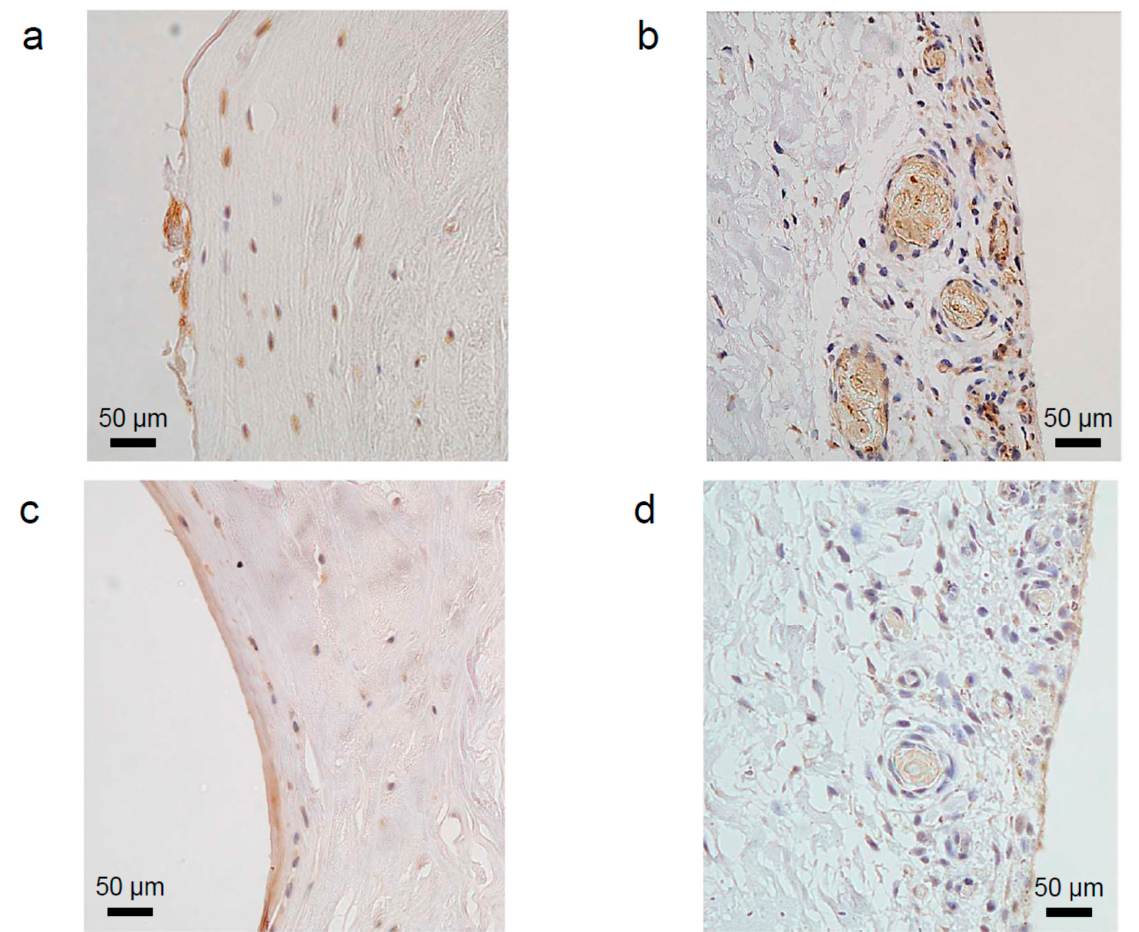
Figure 1. Immunohistochemical staining of vascular endothelial growth factor (VEGF) on the labral surface facing the femoral head ( a ) and the articular capsule ( b ). Immunohistochemical staining of nerve growth factor (NGF) on the labral surface facing the femoral head ( c ) and the articular capsule ( d ). The characteristics of staining in each region showed that the number of cells in the inner region was lower than that in the outer region. In the outer region, only some cells were stained positively. Vascular structures were observed in the labral outer region. Bars represent 50 µm (original magnification, 200×). The nuclei were counterstained with haematoxylin.